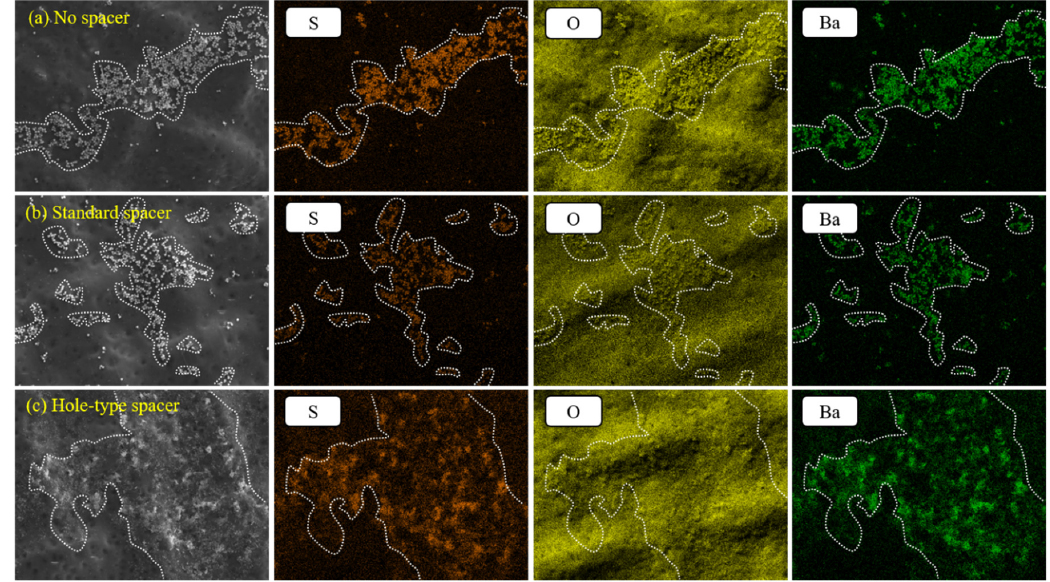
Figure 6. EDX mapping of the active layer surfaces of membranes: ( a ) with no spacer, ( b ) equipped with standard, and ( c ) hole-type spacers.